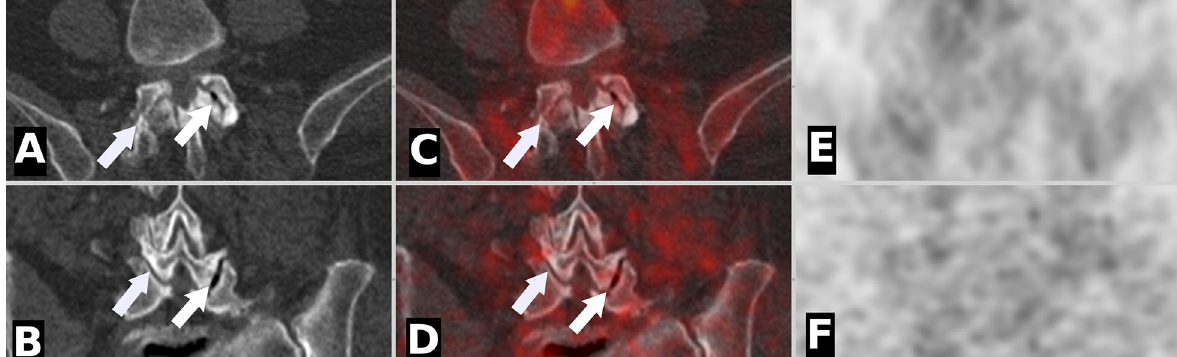
Fig. 3 A case presented with low back pain. Multiplanar PET/CT images including CT bone window axial ( A ) and coronal ( B ). Fused PET/CT axial ( C ) and coronal ( D ). PET axial ( E ) and coronal ( F ). Advanced degenerative CT changes related to bilateral L4/L5 facet joints (arrows) with no abnormal 18F-FDG uptake on the corresponding PET